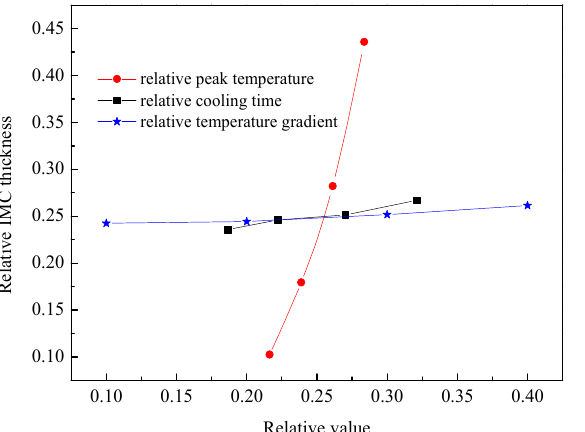
Figure 17. Correlations between the thicknesses of the respective IMCs layers and the peak temper- ature, cooling time, and temperature gradient.